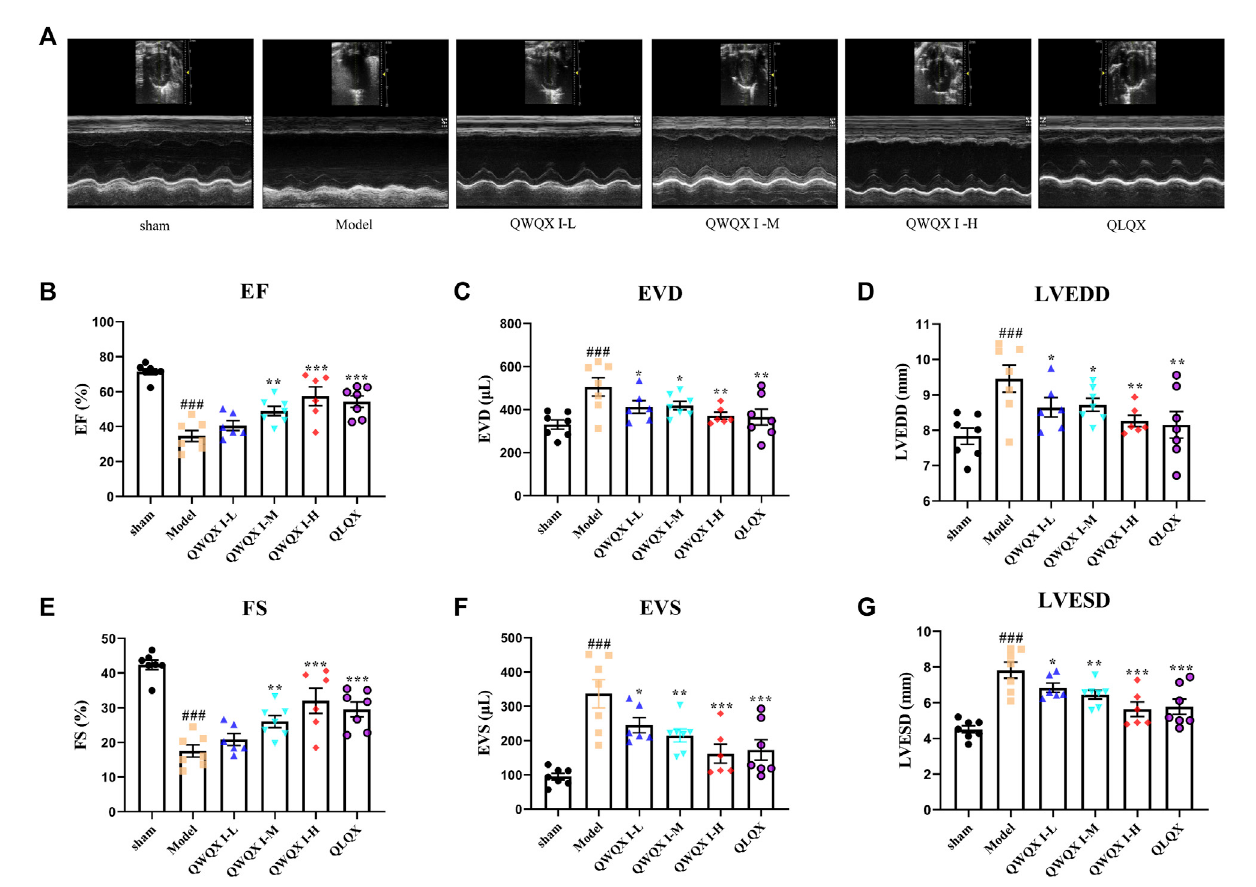
FIGURE 2 QWQX I treatment improved cardiac function in CHF rats. (A) Echocardiography images of rats in different groups. (B – G) Effect of QWQX I on LAD- induced echocardiographic parameters. Data are expressed as the Mean ± SEM. ## p < 0.01, ### p < 0.001, the Model group vs. the sham group; * p < 0.05, ** p < 0.01, *** p < 0.001, drug treatment group vs. the Model